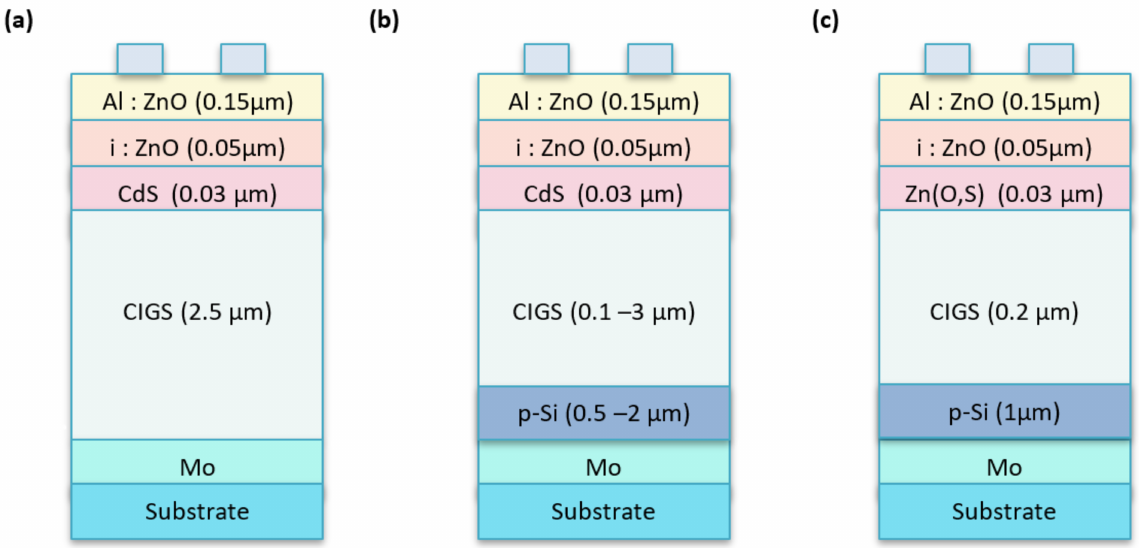
Figure 1. Schematic view of: ( a ) CIGS solar cells. ( b ) New ultra-thin CIGS structure with BSF. ( c ) New ultra-thin CIGS structure with BSF and Zn(O,S) buffer